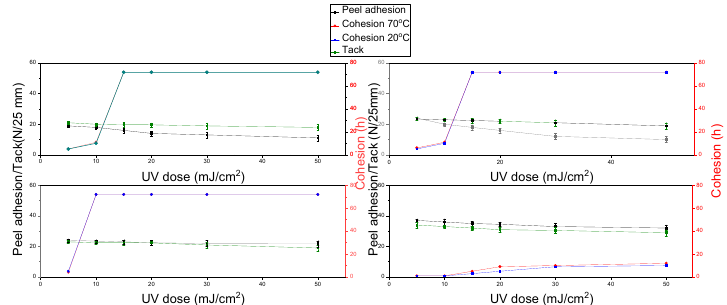
Figure 7. Results of cohesion at 20 °C and 70 °C, peel adhesion, and tack for self-adhesive tapes obtained from acrylate copolymers from P3 synthesis. In order to determine the maximum operating temperature, the obtained self-adhe- sive tapes were subjected to the SAFT test. The results are shown in Figure 8. All obtained products were characterized by high thermal resistance, but the highest results were ob- tained for the acrylate copolymer obtained in the reaction of P3 with butyl acrylate and 2- ethylhexyl acrylate (Figure 8c). Furthermore, tapes made of copolymer with butyl acrylate showed high thermal resistance (Figure 8a). The lowest results were obtained for the acry- late copolymer from reaction P2 (Figure 8b). For all the copolymers obtained, the maxi- mum working temperature was the lowest for the basis weight of 120 g/m 2 . For the re- maining basis weights, the values were high. In the case of an increase in the radiation dose, the maximum operating temperature increased (for the P2 copolymer), whereas in other cases it was difficult to find a relationship. This may have been caused by the use of an insufficient radiation dose, and thus an overly short exposure time, and an overly thick adhesive layer, which would make it difficult for radiation to penetrate the entire adhesive layer.